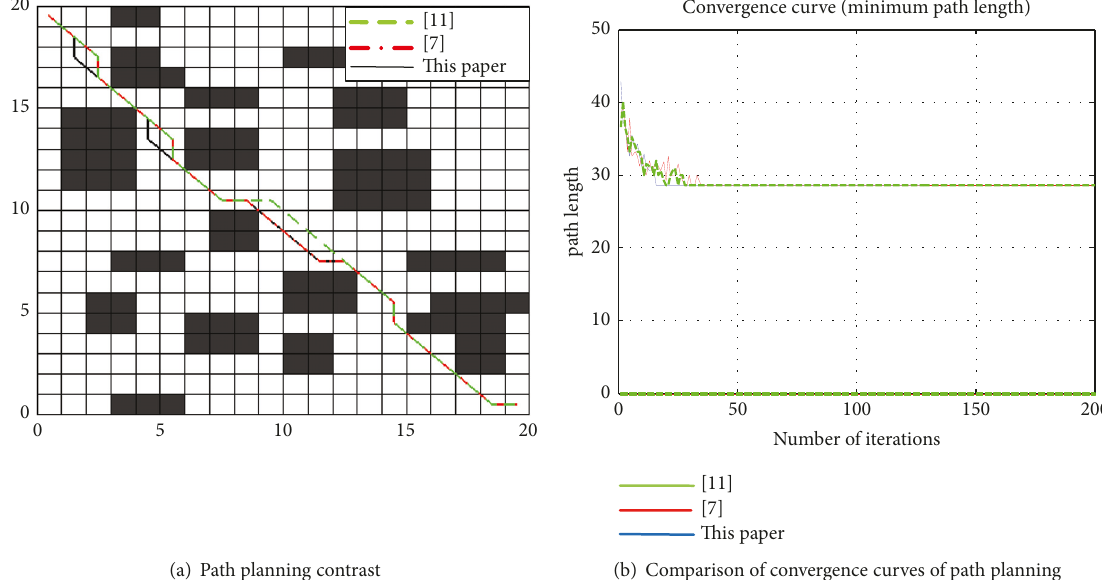
Figure 7: Results of path planning.